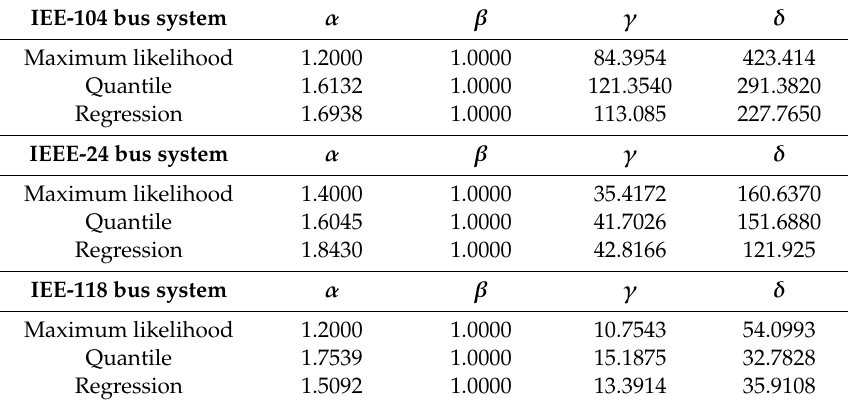
Table 1. Alpha stable